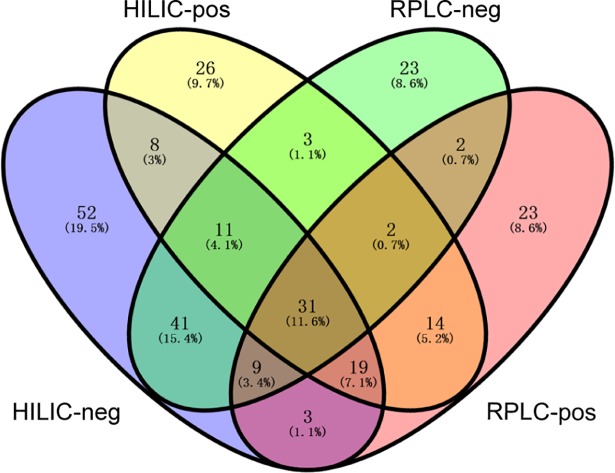
Metabolites from the four datasets identified in this study.HILIC-neg indicates the dataset obtained by hydrophilic interaction liquid chromatography (HILIC)-electrospray ionization (ESI) in negative mode. HILIC-pos indicates the dataset obtained by HILIC-ESI in positive mode. RPLC-neg indicates the dataset obtained by reversed-phase liquid chromatography RPLC-ESI in negative mode. RPLC-pos indicates the dataset obtained by RPLC-ESI in positive mode.